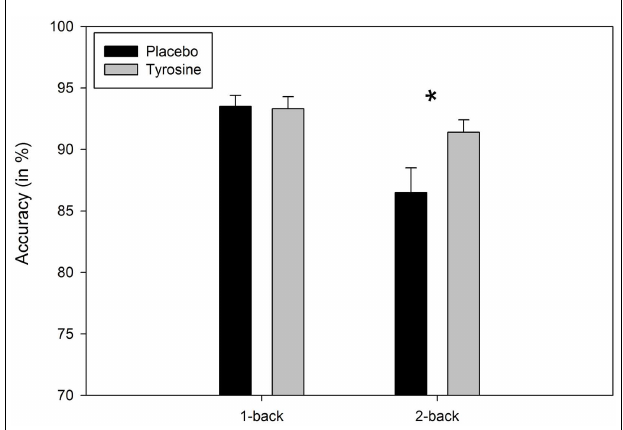
FIGURE 1 | MeanAccuracy (in %) as a function of load (1-back vs. 2-back) and condition (Placebo vs.TYR) . Asterisk indicates significant (* p < 0.05) effect ofTYR on the 2-back task.Vertical capped lines atop bars indicate SE of the mean.